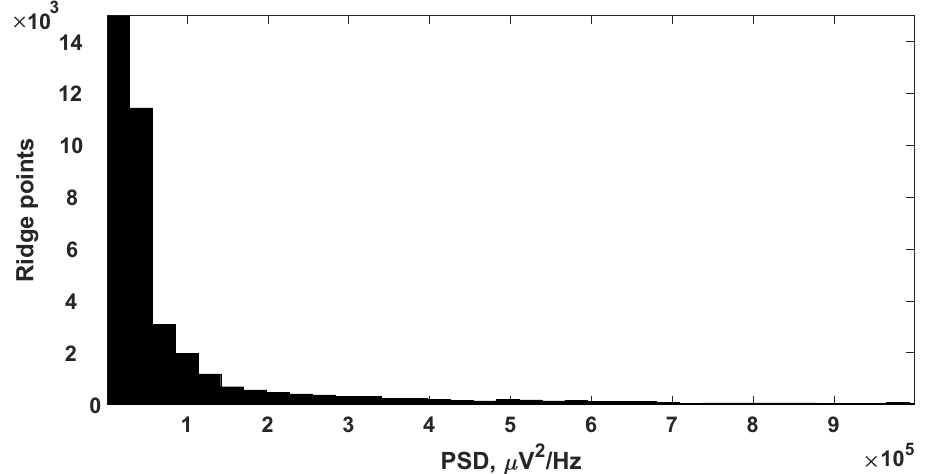
Figure 4. The window of the histogram of the PSD of the wavelet spectrogram ridge of the long-term EEG signal.